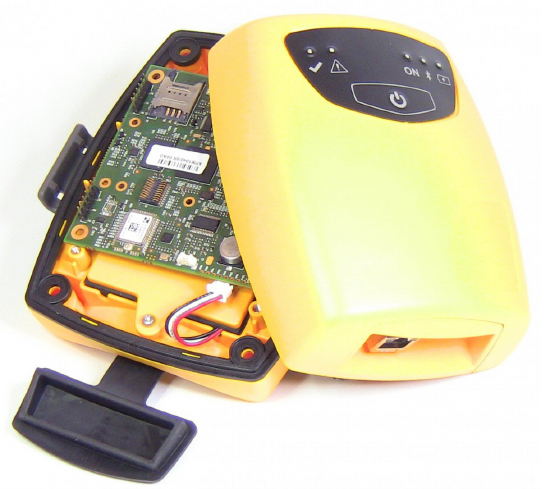
Figure 18. X-Poles is fixed to the pole through an elastic strap. The test starts with a vibration measurement generated by a hammer. Using a built-in accelerometer, the device collects the pole vibrations and then extracts the natural eigenfrequency and evaluates the Ultimate Breaking Strength of the